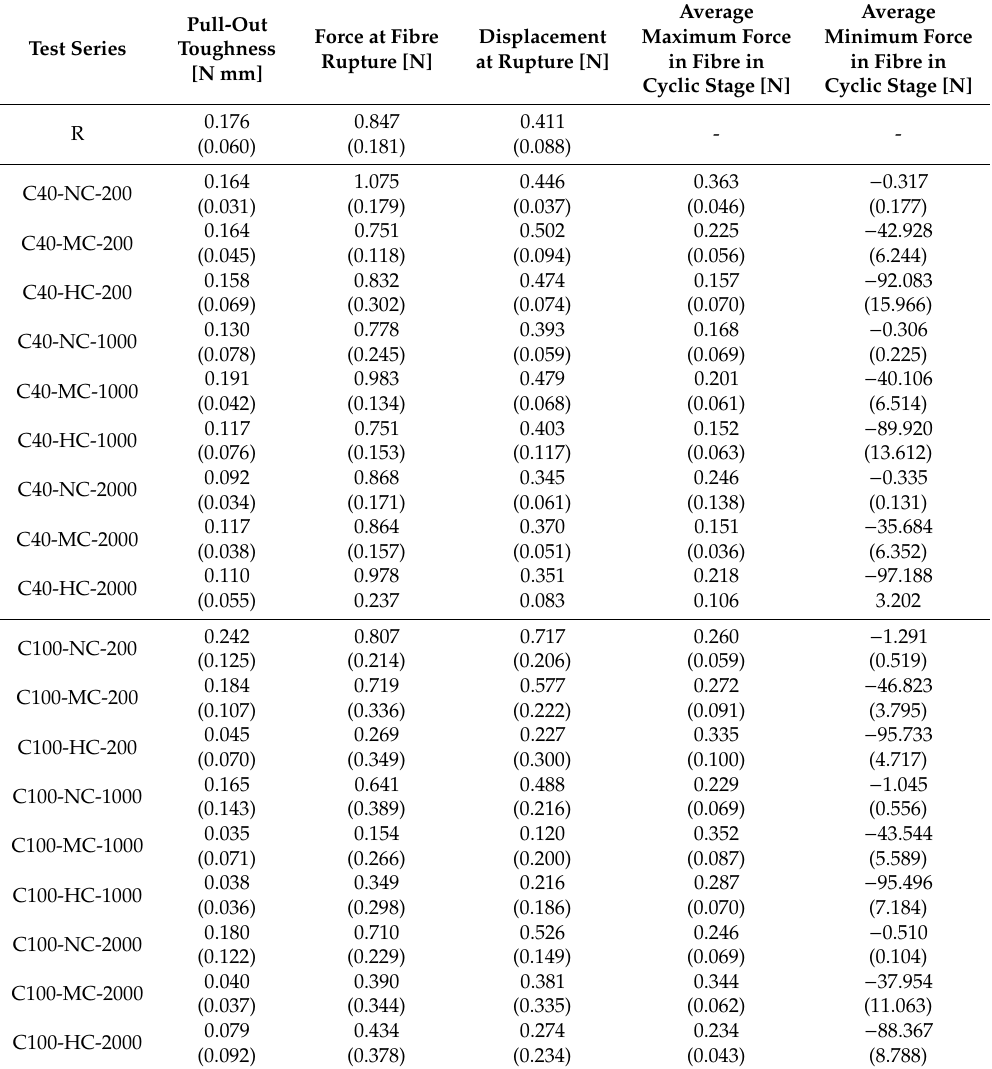
Crack bridging parameters for di ff erent series under investigation; average values (standard deviations are given in